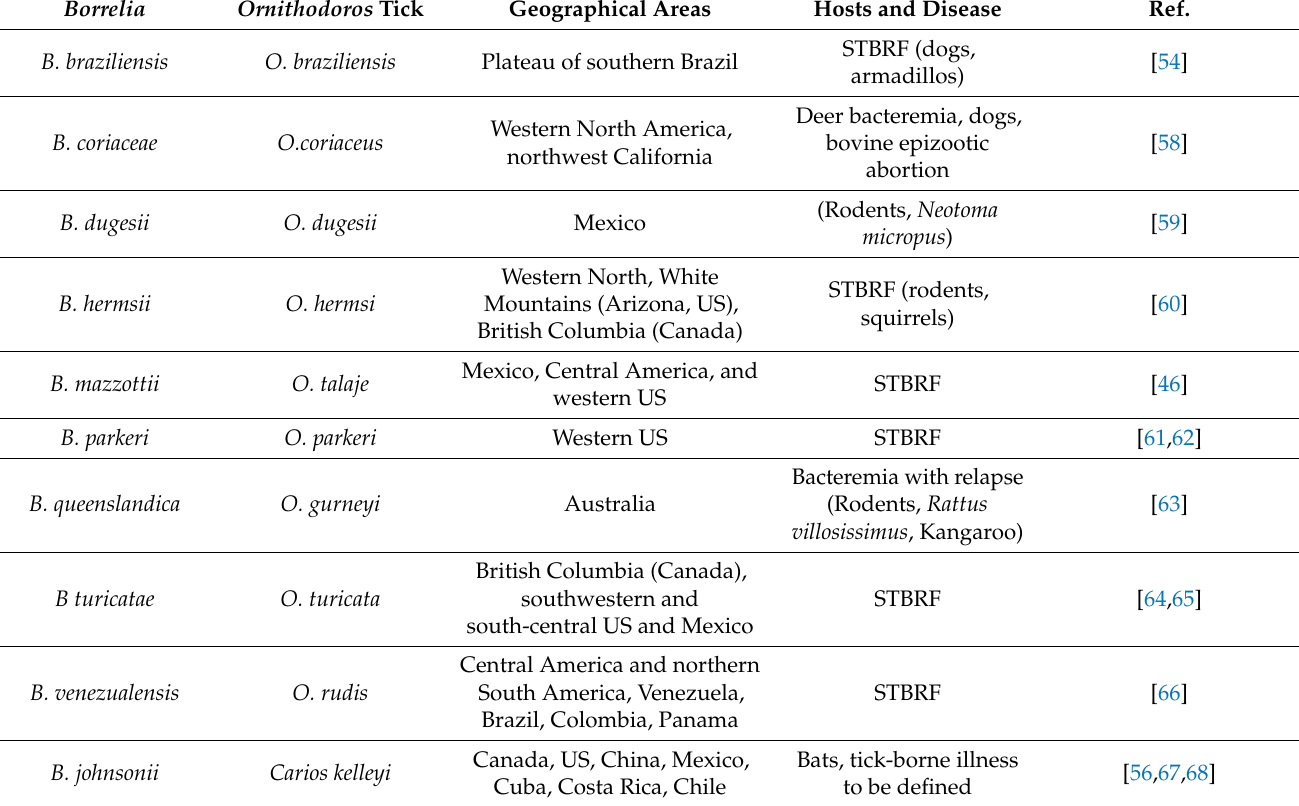
Table 3. New World soft-tick-borne relapsing fever Borreliae with geographical areas and vectors.